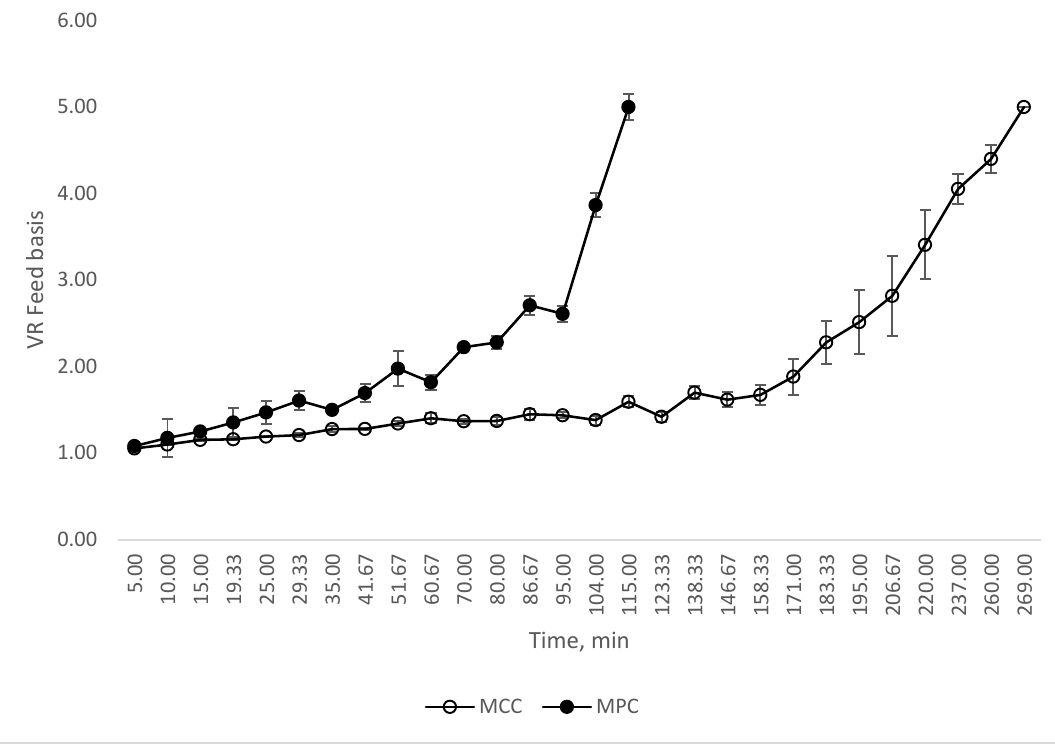
Figure 3. Volume reduction (VR in Liters) on feed basis during MCC and MPC run ( n = 3). Bars depict standard error of mean.